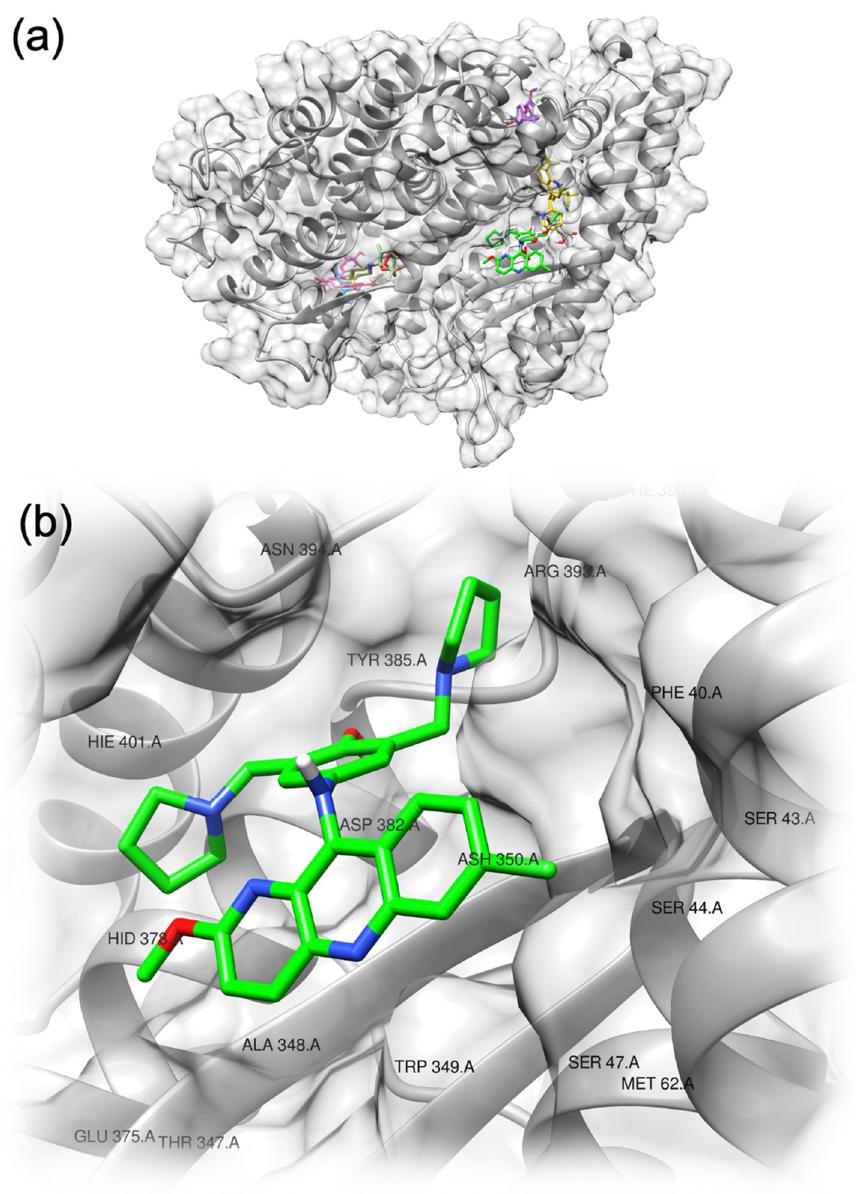
Figure 4. Predicted binding motif for the compounds with ACE2 ( a ). Detailed view of the residues interacting with pyronaridine ( b ). interacting with pyronaridine ( b